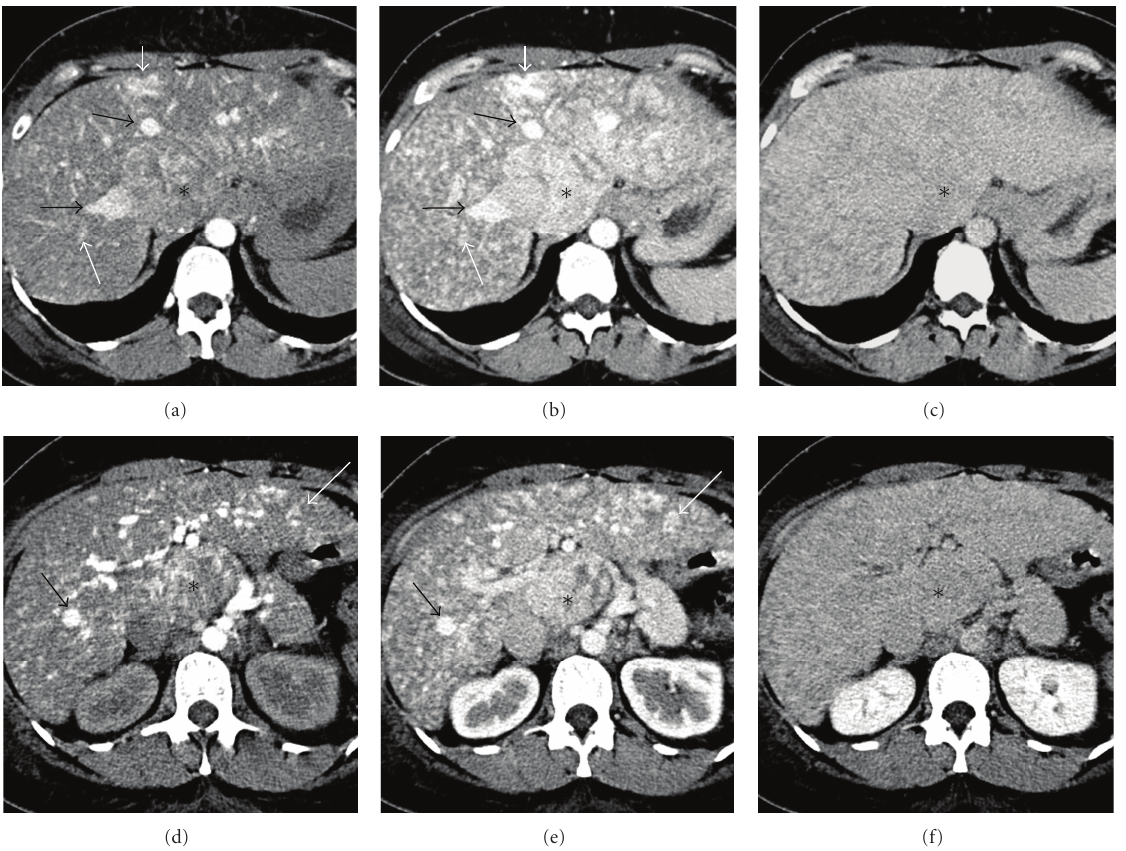
Figure 2: Axial CT scans obtained from di ff erent levels in the early arterial phase (a, d), late arterial phase (b, e) and late venous phase (c, f). During the arterial phases, millimetric hypervascular images disseminated throughout the hepatic parenchyma, referring to telangiectases that are no longer evident during the late venous phase are seen (white arrows). The early venous drainage with the simultaneous opacification of the dilated hepatic veins (black arrows) and the hepatic artery is evident during both arterial phases. Large confluent vascular masses are evident in the caudate lob ( ∗ ). A strongly enhancing subcapsular area with irregular shape, relating to an area of transient hepatic parenchymal enhancement (arrowheads), is evident in the fourth segment. These changes are no longer evident during the late venous